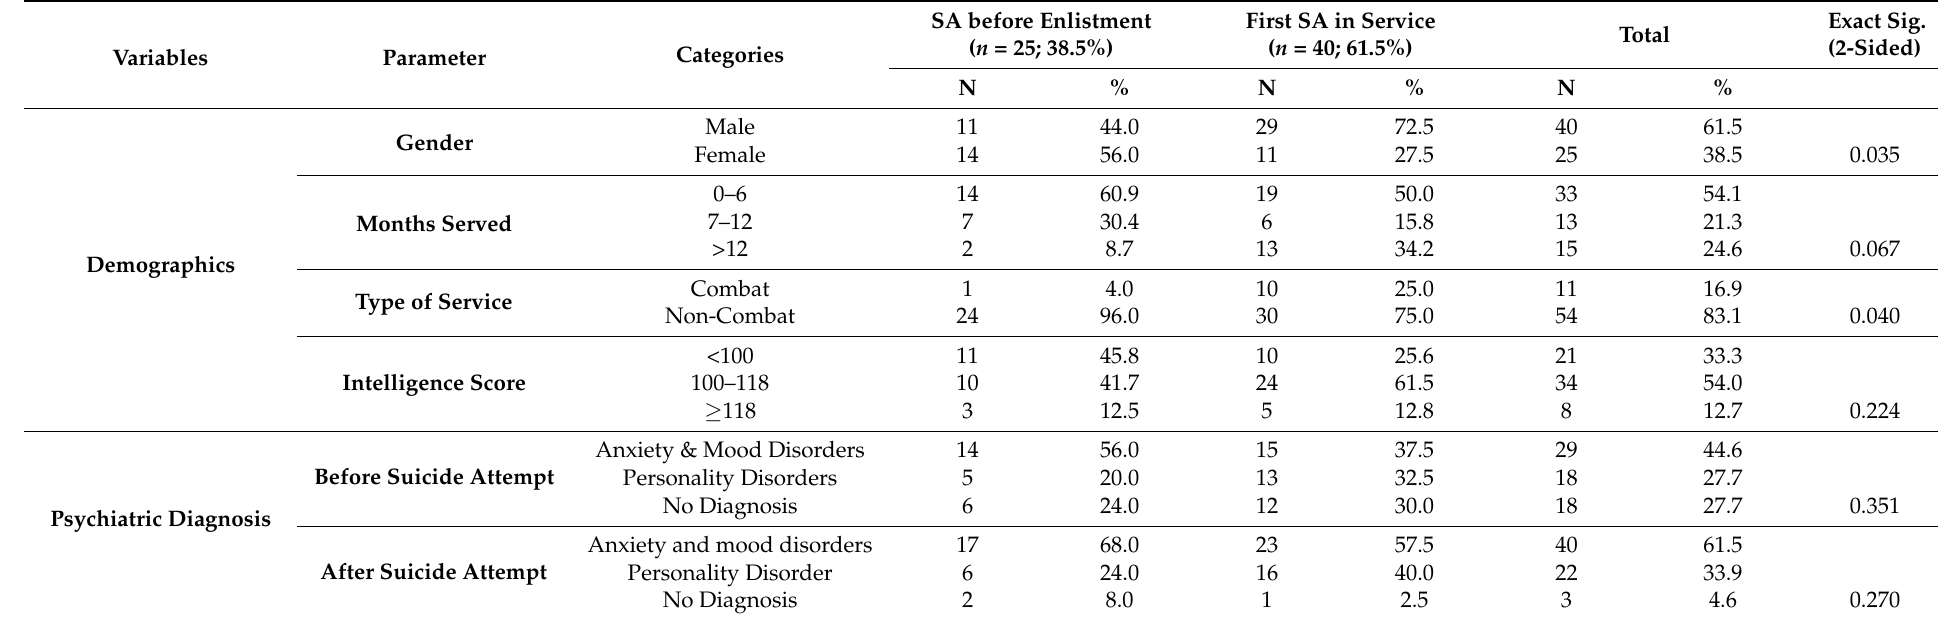
Table 1. Suicidal Characteristics by Suicide Attempt Before Enlistment and First SA in service